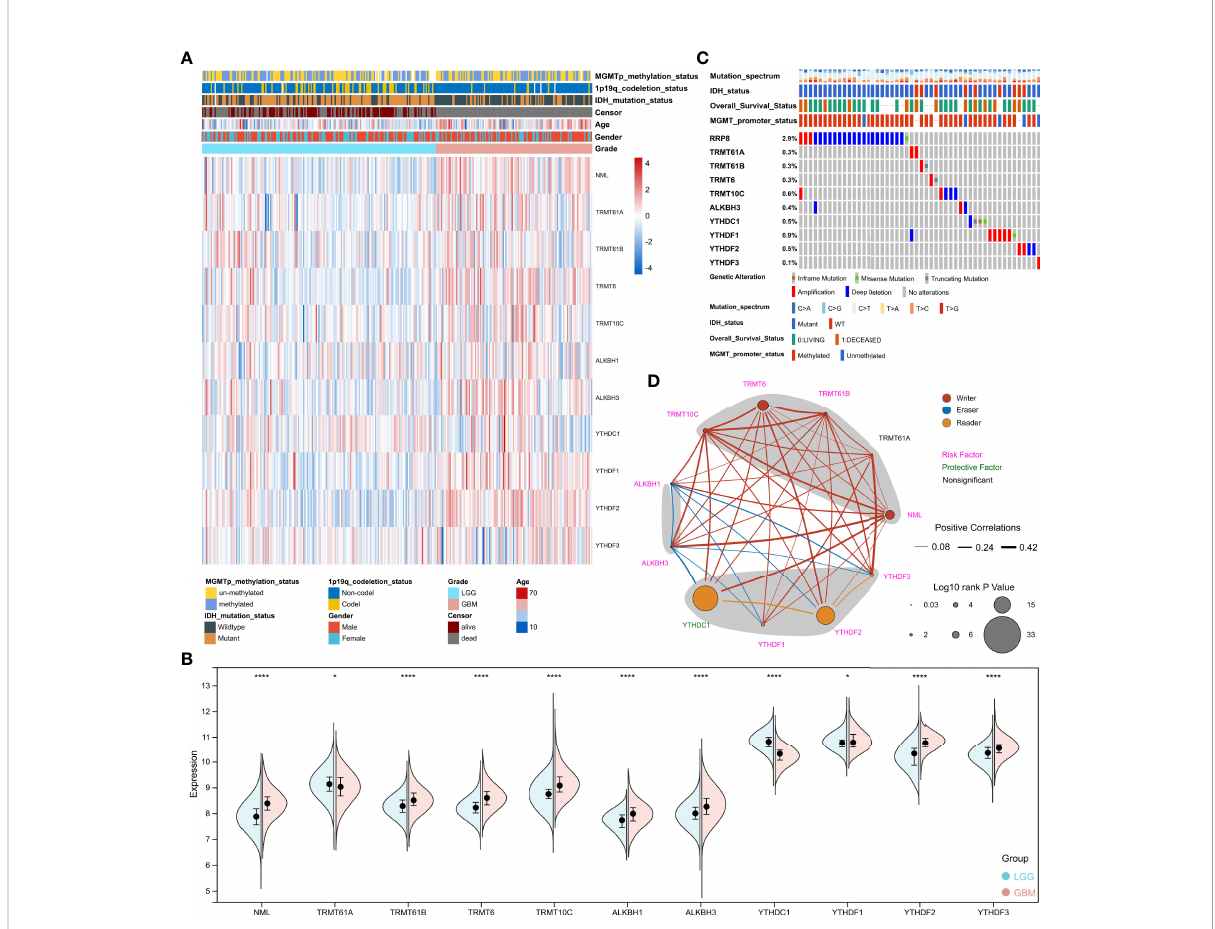
FIGURE 2 Analysis of m 1 A regulators in glioma. (A) Heatmap depicting the expression of m 1 A regulators in the TCGA cohort. (B) Spilt violin showing the expression of m 1 A regulators between LGG and GBM. (C) Mutation waterfall chart displaying the mutation on m 1 A regulators in glioma. (D) The network displaying the relationship and prognosis information of m 1 A regulators. *, P< 0.05; ****, P<